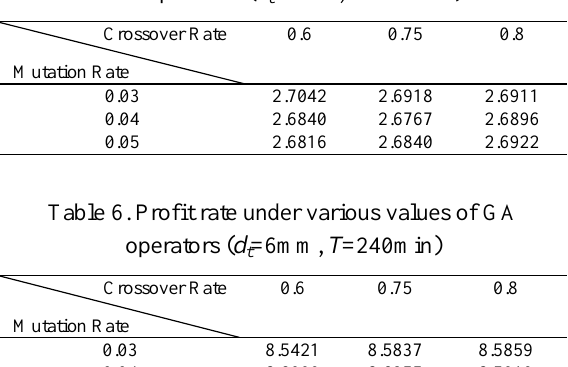
Table 5. Unit machining time under various values of GA operators ( d t =6mm, T =240min)